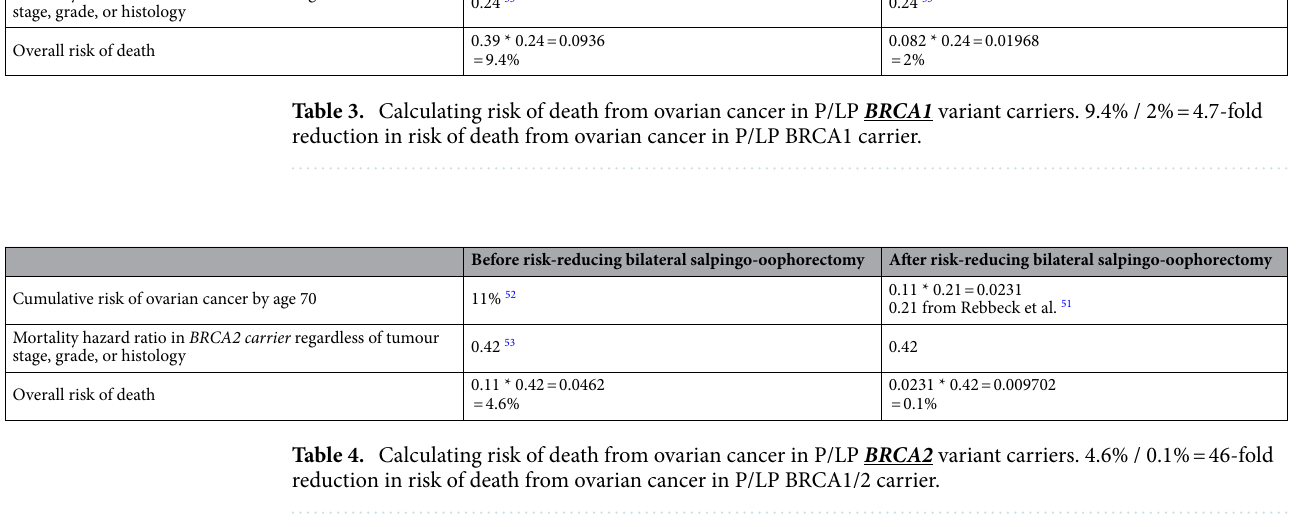
Table 4. Calculating risk of death from ovarian cancer in P/LP BRCA2 variant carriers. 4.6% / 0.1% = 46-fold reduction in risk of death from ovarian cancer in P/LP BRCA1/2 carrier.